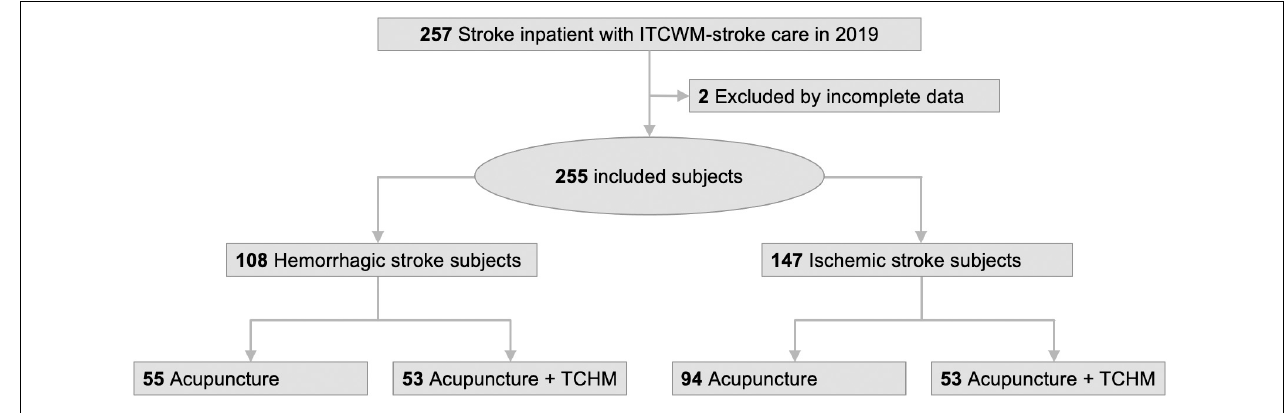
FIGURE 1 | Study flow